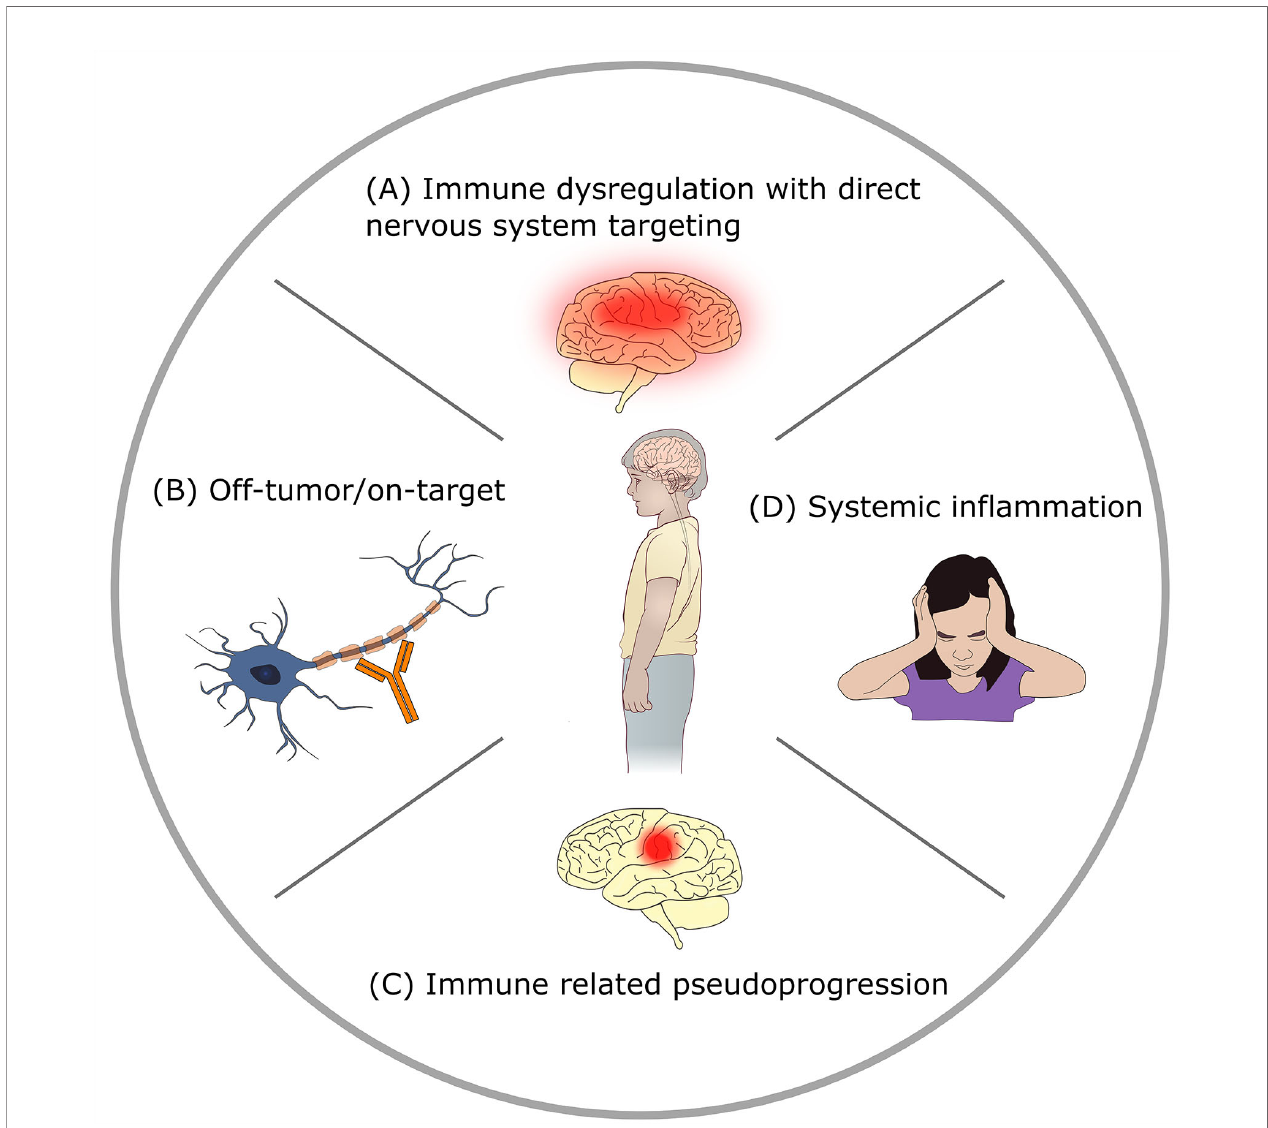
FIGURE 1 | Mechanisms of neurotoxicity in immunotherapy. (A) Direct targeting of the nervous system by immune dysregulation: immunotherapy provokes autoimmunity or other immune-mediated CNS injury. Examples: checkpoint-blockade related encephalitis, immune effector cell associated neurotoxicity syndrome (ICANS). (B) Off-tumor on-target toxicity: immunotherapy agent targets normal tissue. Example: GD2 antibody mediated peripheral neuropathy. (C) Immune related pseudoprogression: targeting of tumor by immunotherapy causes peritumoral in fl ammation with increased edema. Example: tumor in fl ammation associated neurotoxicity (TIAN) related to GD2-CAR T therapy for brain tumors. (D) Systemic in fl ammation related neurologic signs and symptoms: neurologic symptoms in the setting of elevated systemic in fl ammatory states with absence of direct CNS injury. Example: headache after anti-tumor